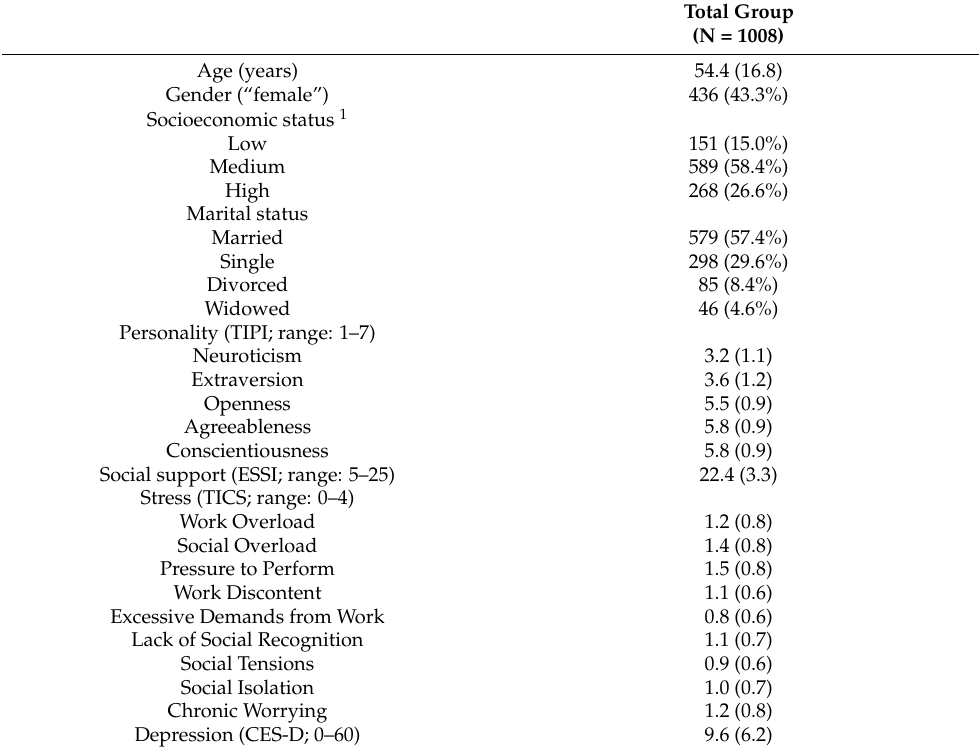
Table 1. General characteristics of the study population.